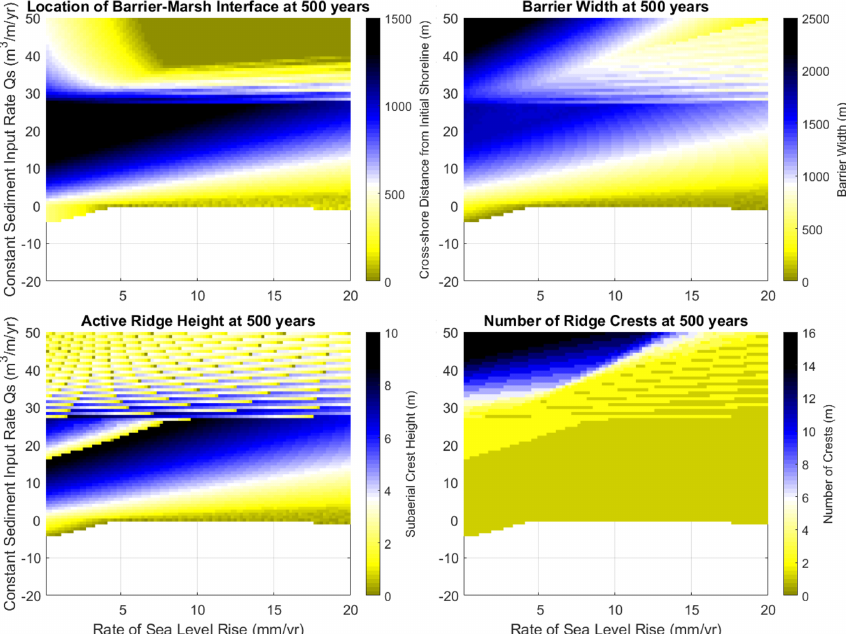
Figure 8. Plots of barrier–marsh interface location x b , barrier width W , active foredune crest height H , and number of foredune ridges N for a 500-year simulation of a modeled barrier with input parameters described by Table 3 and D T = 5m. Regions with no data (generally negative sediment input) correspond with complete dune loss and potential barrier disintegration. D T is the thickness of the barrier substructure or the depth of the active shoreface over decadal timescales. Q S represents shoreface flux. Note that the active ridge height and number of ridge crests do not change synchronously at the end of each 500-year simulation due to the presence of amalgamation. Discontinuities in the plot of active ridge height generally align with the plot of ridge crests produced, but where they differ it is because amalgamation can reduce the number of ridges while maintaining the height of the active